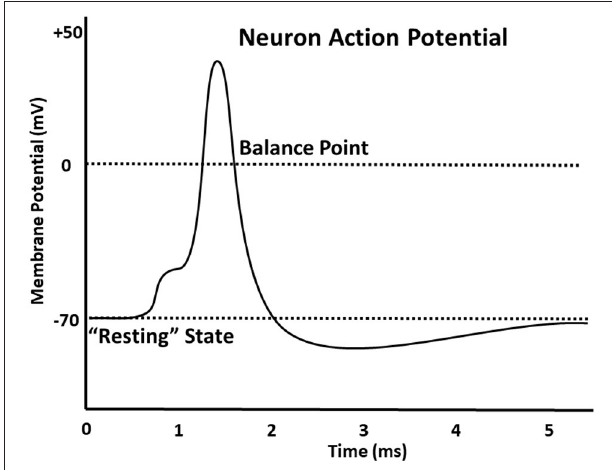
FIGURE 2 | Neuron action potential. Teaching graphic used to describe changes in the electrical balance of a stimulated neuron over time.